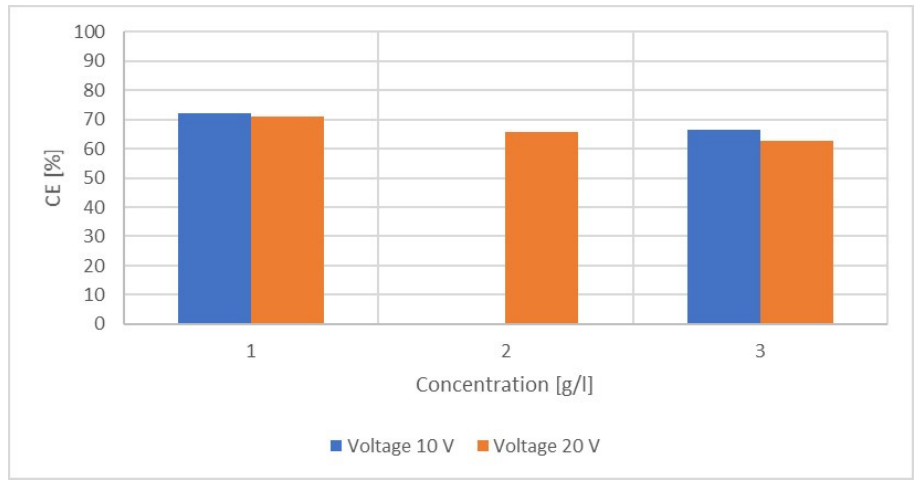
Figure 4. CE as a function of the concentration of LiCl in an aqueous solution for varying voltages at ϑ = 21 °C.